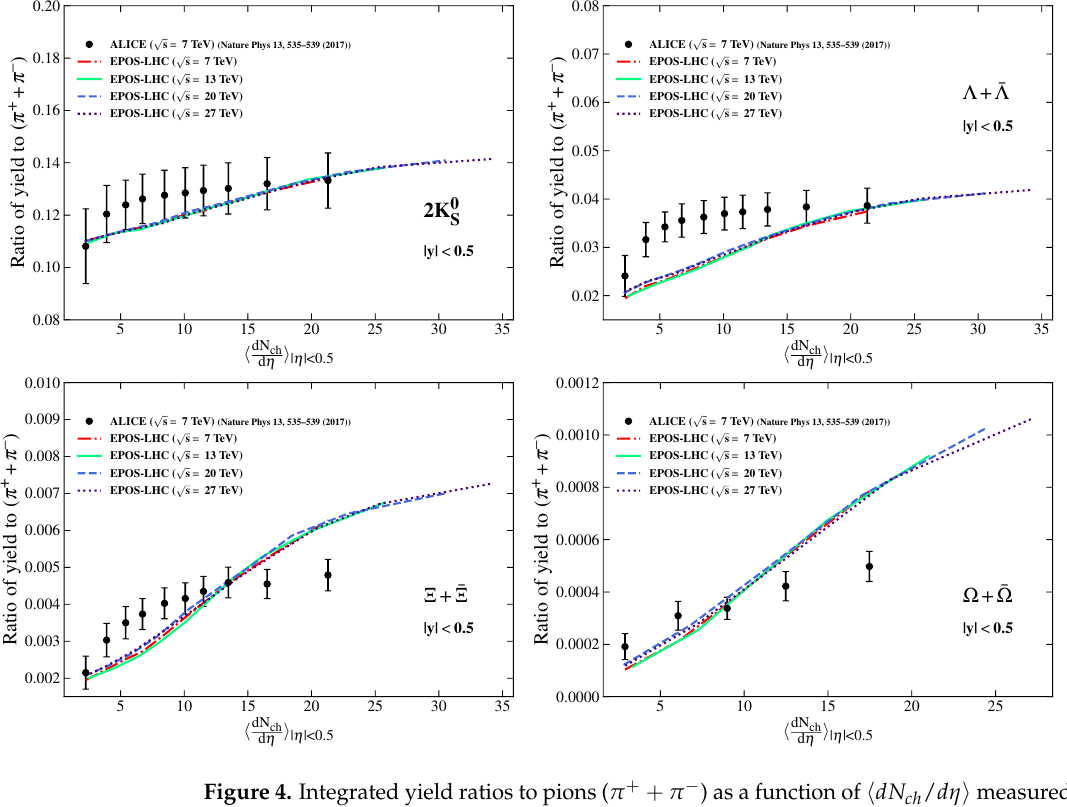
Figure 4. Integrated yield ratios to pions ( π + + π − ) as a function of at √ s = 7 TeV, 13 TeV, 20 TeV, and 27 TeV using EPOS-LHC [25].